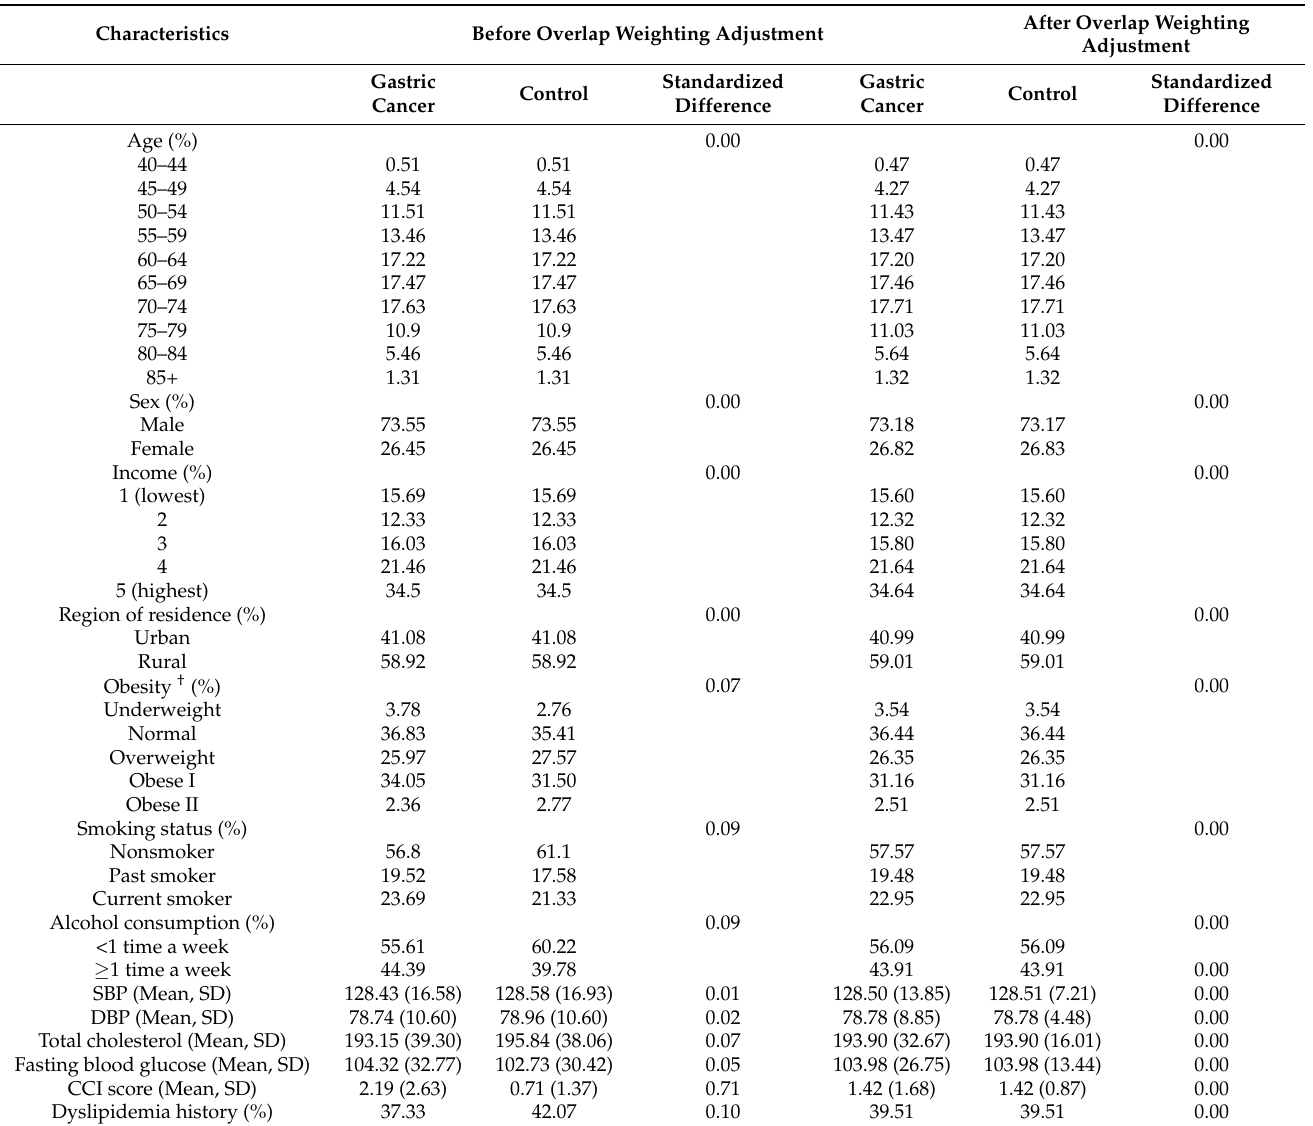
Table 1. Baseline characteristics of